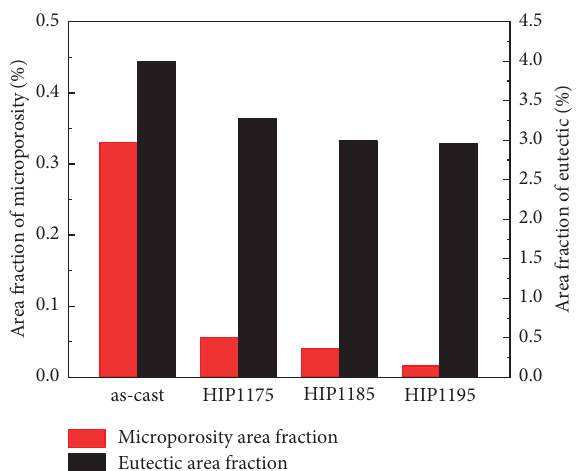
Figure 4: Area fraction of the microporosity and eutectic of the K417G alloy in as-cast and HIP